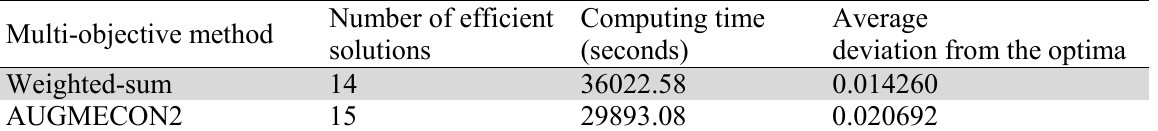
Results for third scenario and twenty grid points.